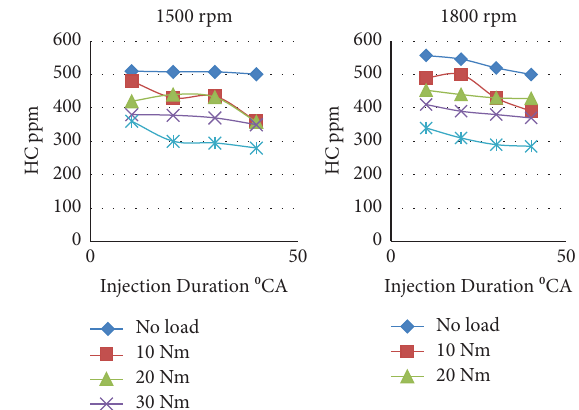
Figure 6: HC emission for diferent H of 1800rpm and